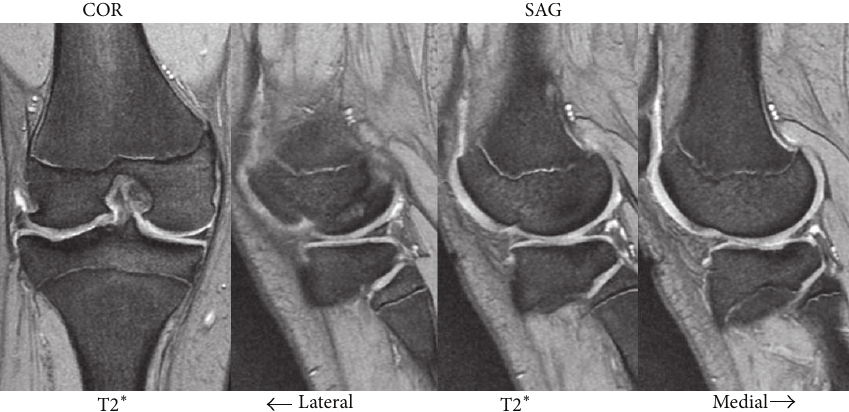
Figure 7: MRI showing that the defect of the tibial lateral condyle articular cartilage was covered with